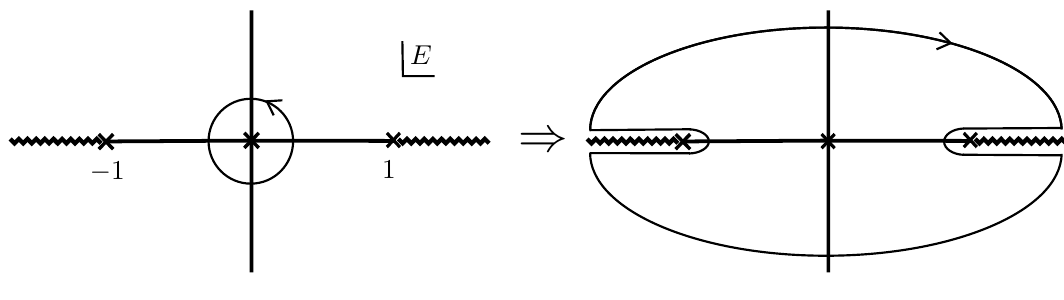
Figure 1 . Relation between low-energy coe(cid:14)cients and discontinuity. Analyticity in spin holds if the arcs at in(cid:12)nity (the Regge limit) can be